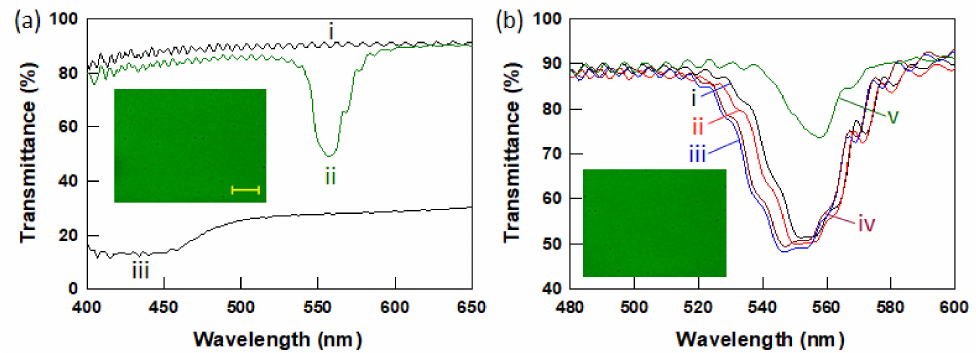
Figure 5. Polymer-stabilized BPLC-3 containing 0.5 wt% photoinitiator (Omnirad 651): ( a ) Before UV exposure at ( i ) 38.5 ◦ C, ( ii ) 29 ◦ C, and ( iii ) 20 ◦ C; and ( b ) after UV exposure at 29 ◦ C with 1 mW cm − 2 365 nm wavelength UV light for 20 min. Temperature decreases from ( i ) 29 ◦ C, ( ii ) 25 ◦ C to ( iii ) 3 ◦ C,